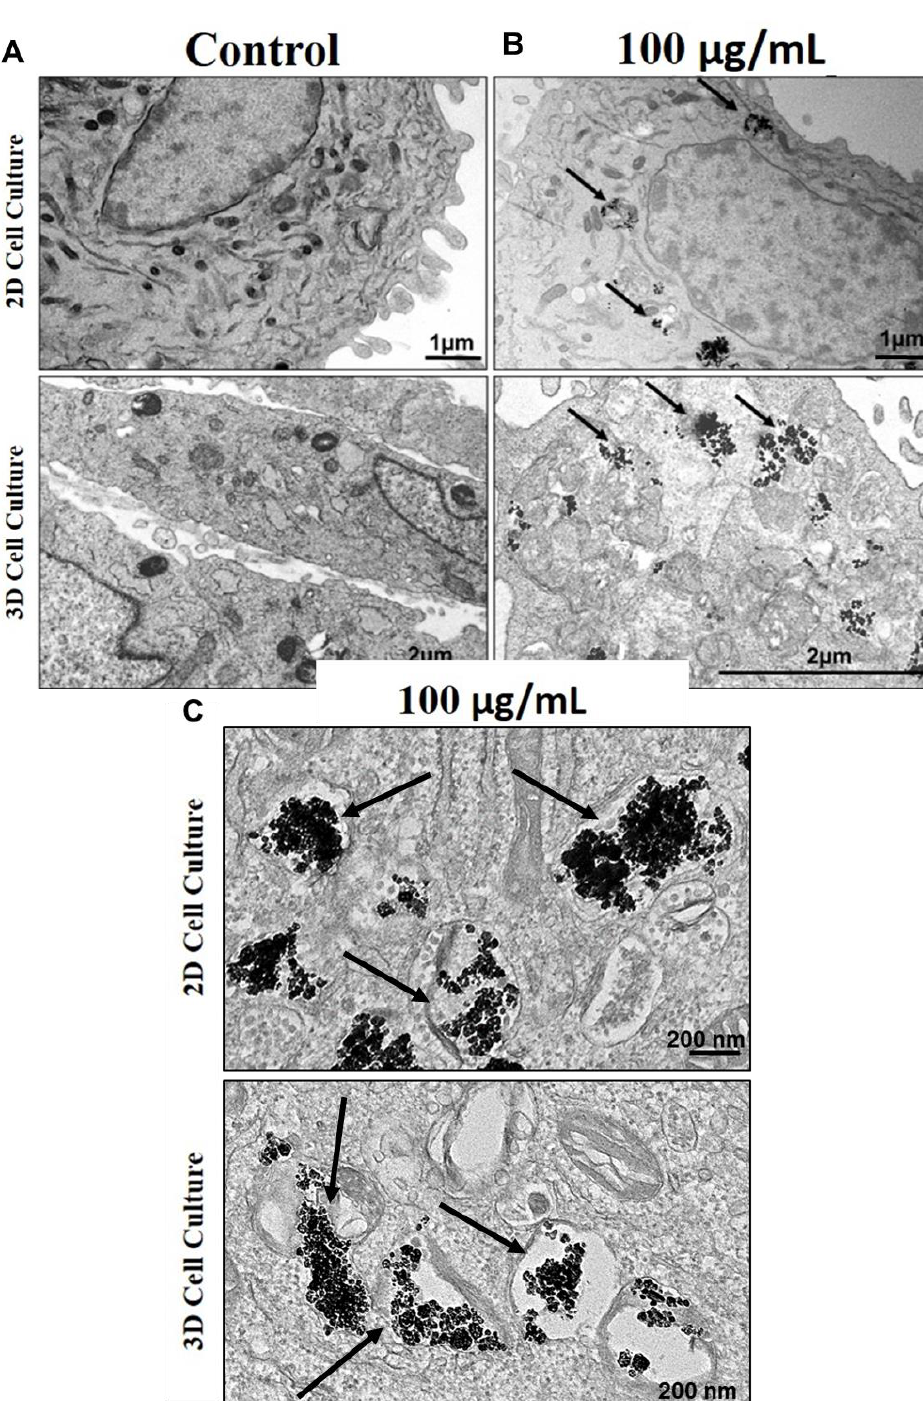
Figure 5. Internalization of TiO 2 NPs: Transmission electron microscopy (TEM) micrographs showing TiO 2 NPs internalization in human osteoblasts (SAOS-2) 72 h cultured: ( A ) control, cultured without NPs or ( B , C ) treated with 100 µ g/mL of TiO 2 NPs (black arrow). The results are representative images of three independent experiments. (scale bar: 1 µ m, 2 µ m, and 200 nm). To compare differences in mineralization occurring in 2D and 3D models, we per- formed alizarin staining after 3, 7, and 14 days after 5 μg/mL or 100 μg/mL TiO 2 NPs ex- posure in both models. Alizarin red results showed a significant dose-dependent increase